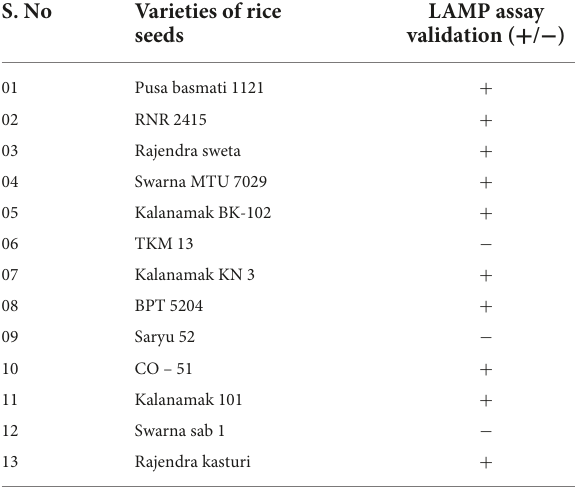
TABLE 3 Details of rice varieties used in the study. S. No